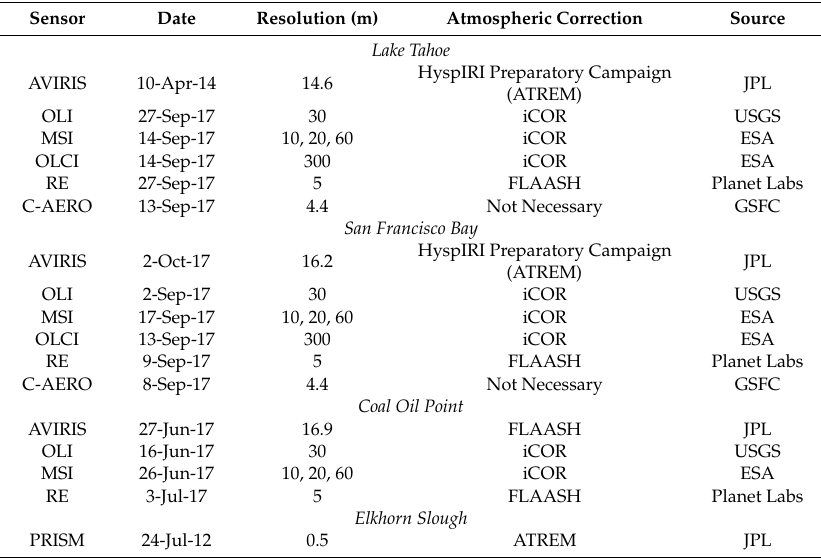
Table 1. Summary of data collection and processing